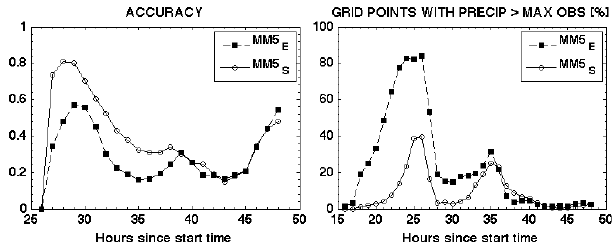
Fig. 9. Left panel: overall accuracy of MM5 in domain 4 as a func- tion of time (hours into the simulation with start time at 00:00UTC, 25 April). Right panel: percentage of grid points in domain 4 with 6h accumulated precipitation higher than the maximum amount ob- served at each hour, for the MM5 E and MM5 S simulations, vs. time (hours since start time).